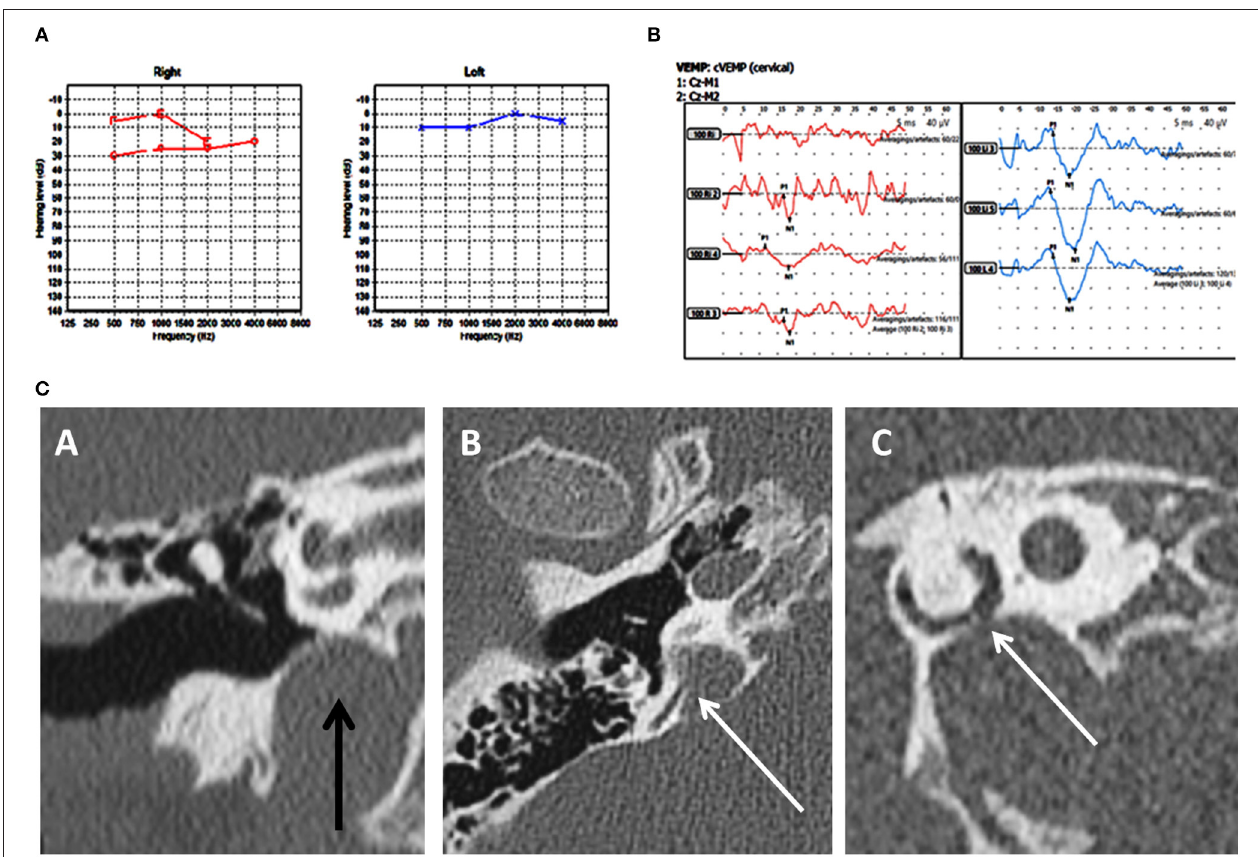
FIGURE 1 | Case number 2—Unilateral right posterior semicircular dehiscence. (A) , Pure tone audiometry showing mild conductive low frequency hearing loss on the right. (B) , Clinically significant cVEMP amplitude asymmetry with the right weaker than the left. This child perceived significant balance issues but his vestibular tests including the vHIT was normal. (C) —CT scan images of the right petrous temporal bone in the coronal plane (A) demonstrates a high riding jugular bulb. The axial image (B) the sagittal oblique reconstruction parallel to the posterior semi-circular canal (C) demonstrate dehiscence of the posterior semi-circular canal at its junction with the jugular